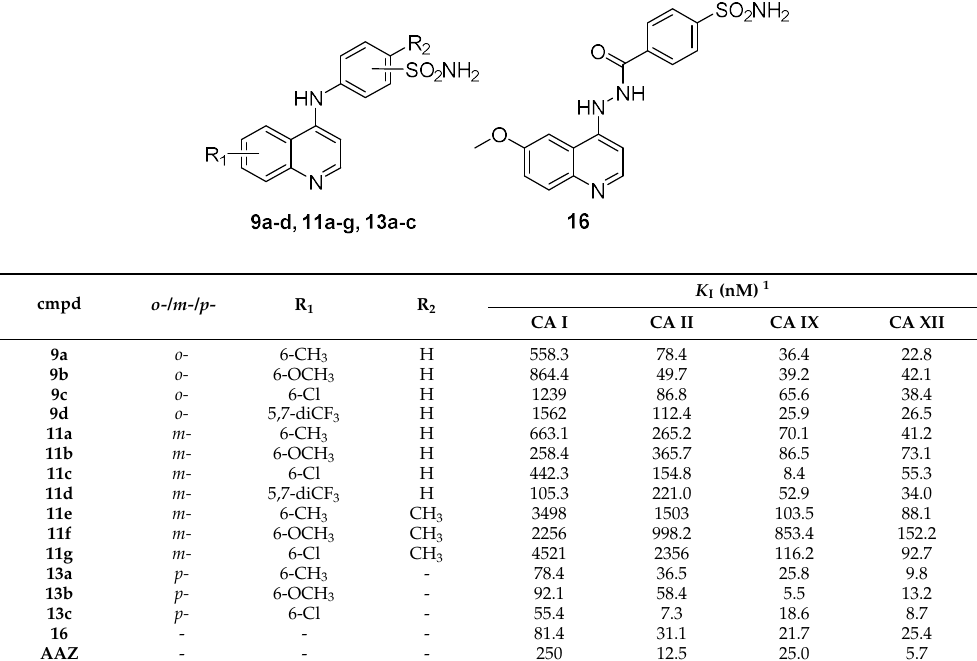
Table 1. Inhibition data for the target sulfonamides on human CA isoforms h CA I, II, IX and XII using AAZ as a reference drug.